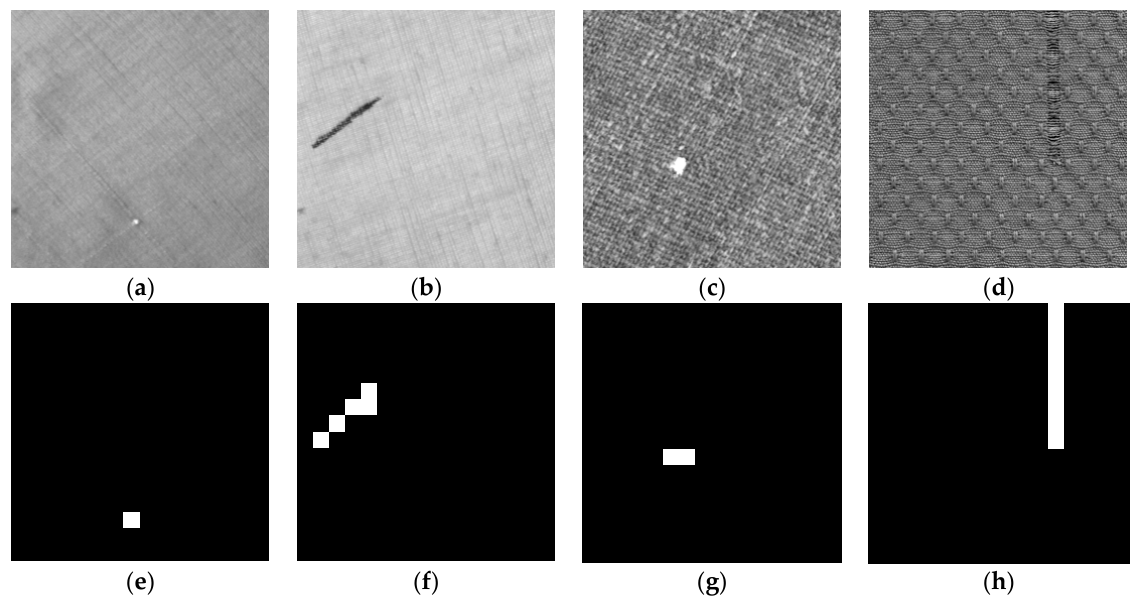
Figure 5. The effectiveness of local difference analysis. ( a – d ) The defective images; ( e – h ) The mask images corresponding to ( a – d ).